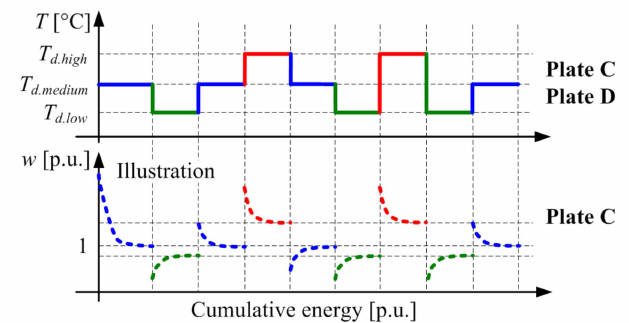
Figure 5. Testing plan related to detailed characterization of moisture influence on wear